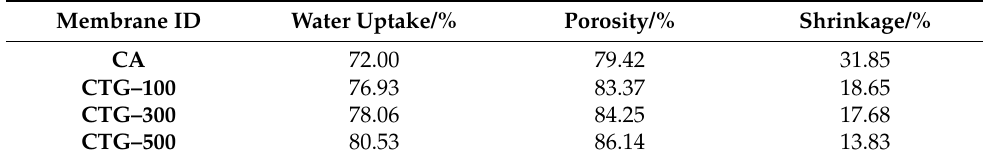
Table 2. Evaluation of membrane water uptake, porosity and shrinkage.